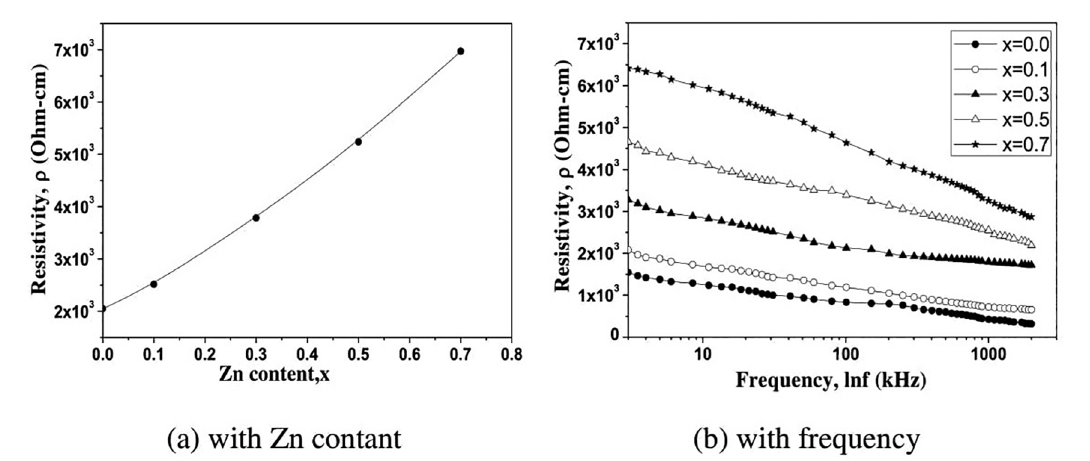
Figure 2. Variation of resistivity with (a) Zn content and (b) frequency.